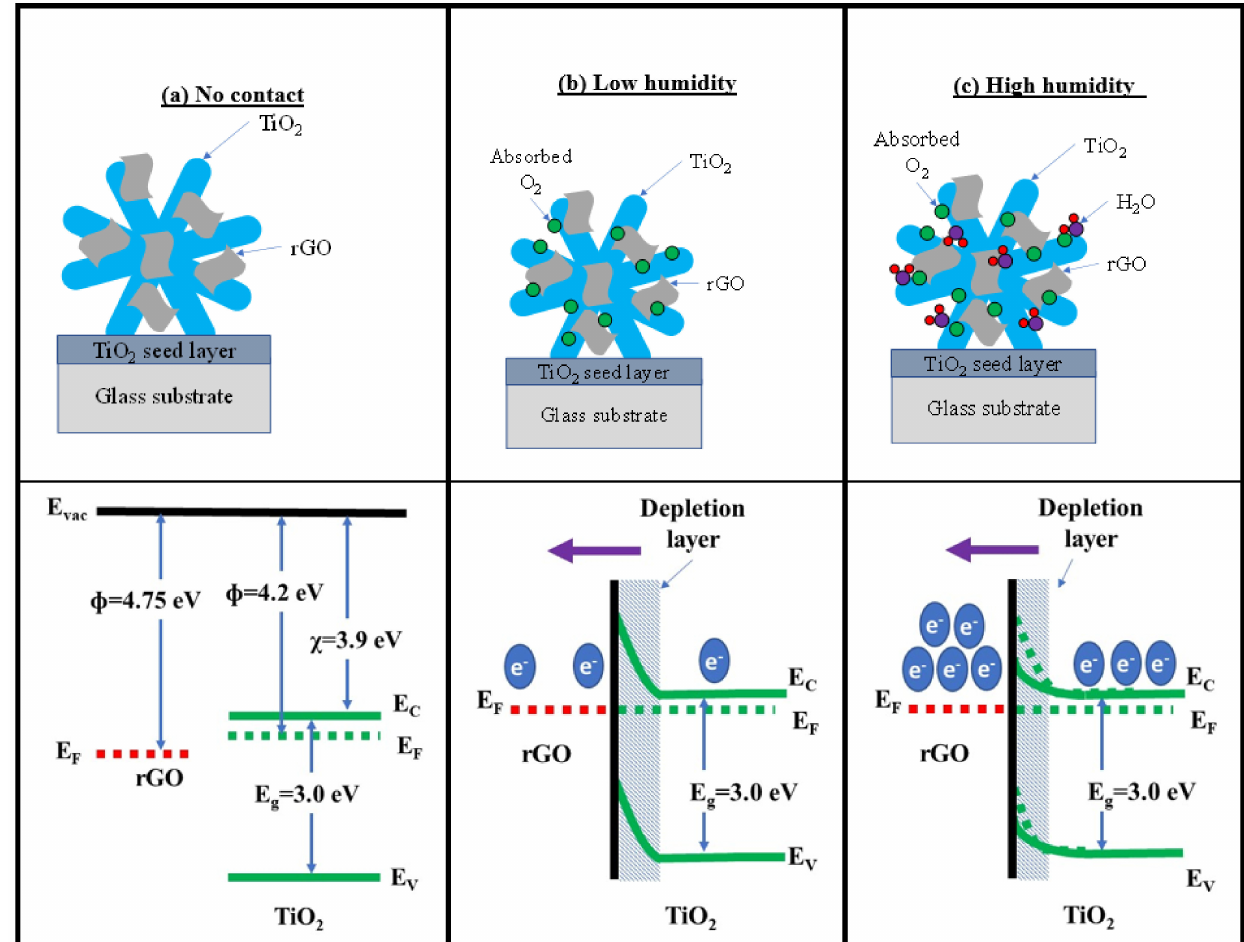
Figure 12. Proposed energy band diagram of the TiO 2 /rGO humidity